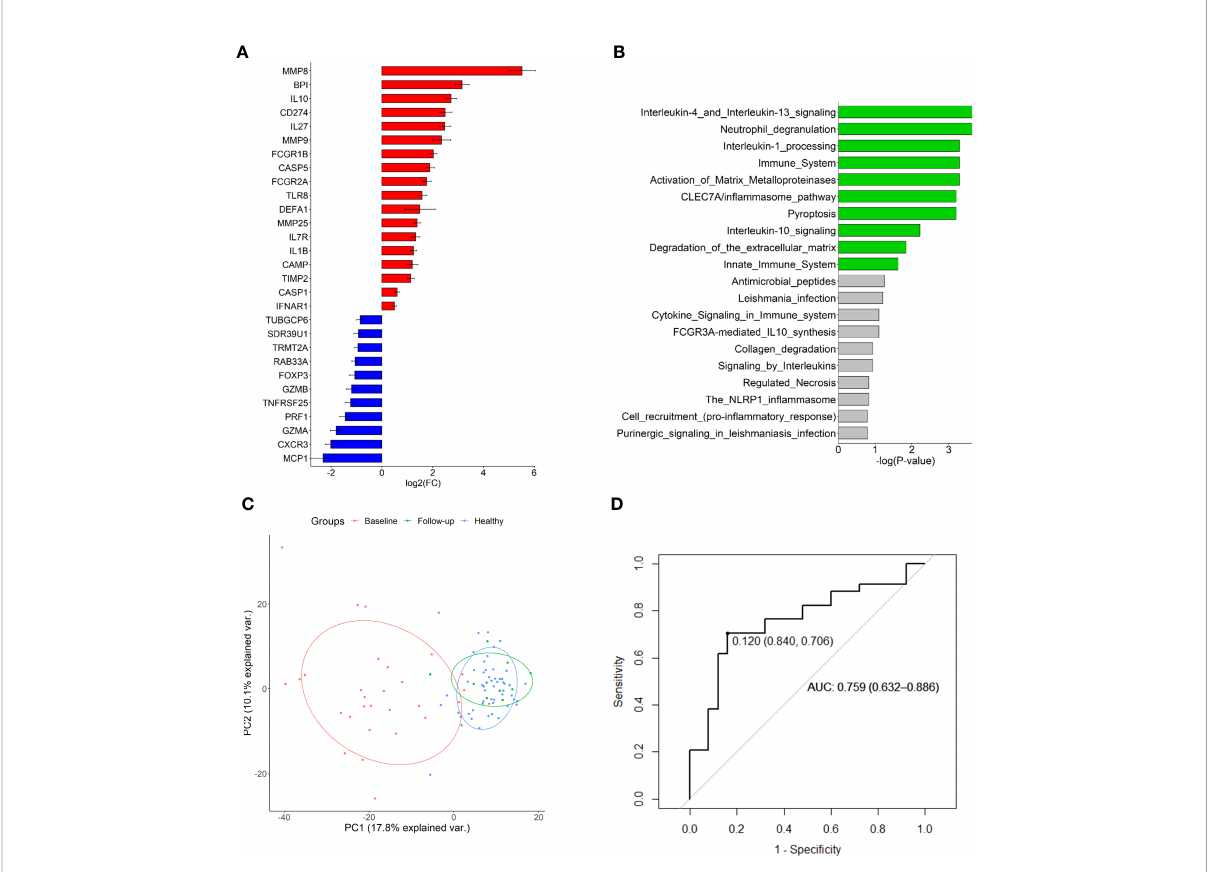
FIGURE 1 Differentially expressed genes in MIS-C. (A) Up-and down-regulated genes compared to healthy controls and (B) overrepresented Reactome pathways in the up-regulated gene set. Green bars indicate those with FDR < 0.05. (C) Principal component analysis of all investigated gene expression values in healthy controls and MIS-C at baseline and follow-up (mean 555.5 days). Plotted are principal components 1 and 2. (D) Receiver operating characteristic curve of IL27 expression discriminating MIS-C from other febrile